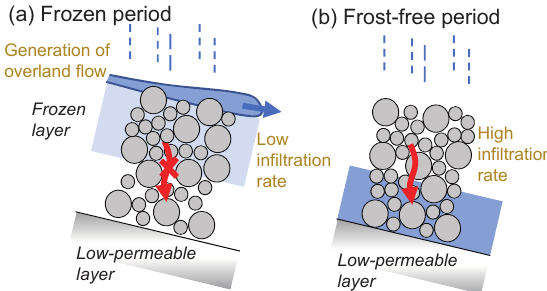
Figure 13. Schematic diagram of the hydrological characteristics of the Osawa failure. (a) Frozen periods. The layer with the ice in the soil matrix is colored light blue. (b) Unfrozen